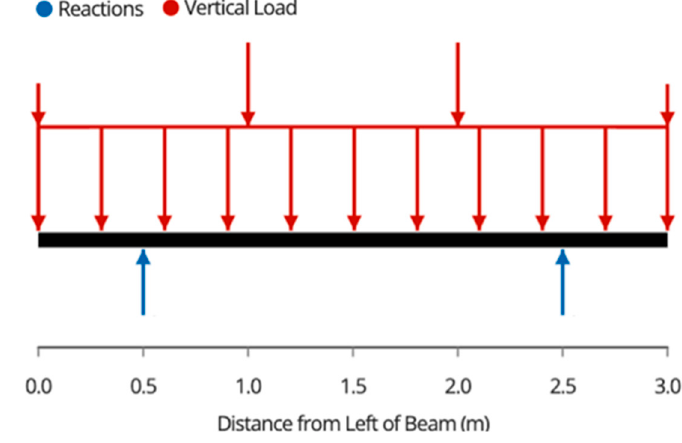
Figure A5. Beam free body diagram.